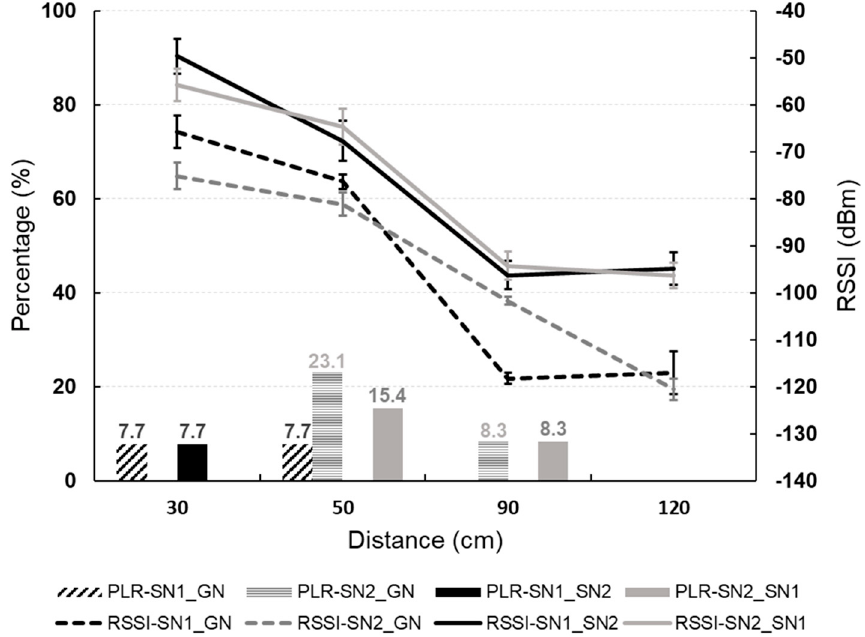
Figure 5. Peer-to-peer transmission test: the difference between the solid and dashed lines demonstrates signal attenuation caused by transmission through the different media.